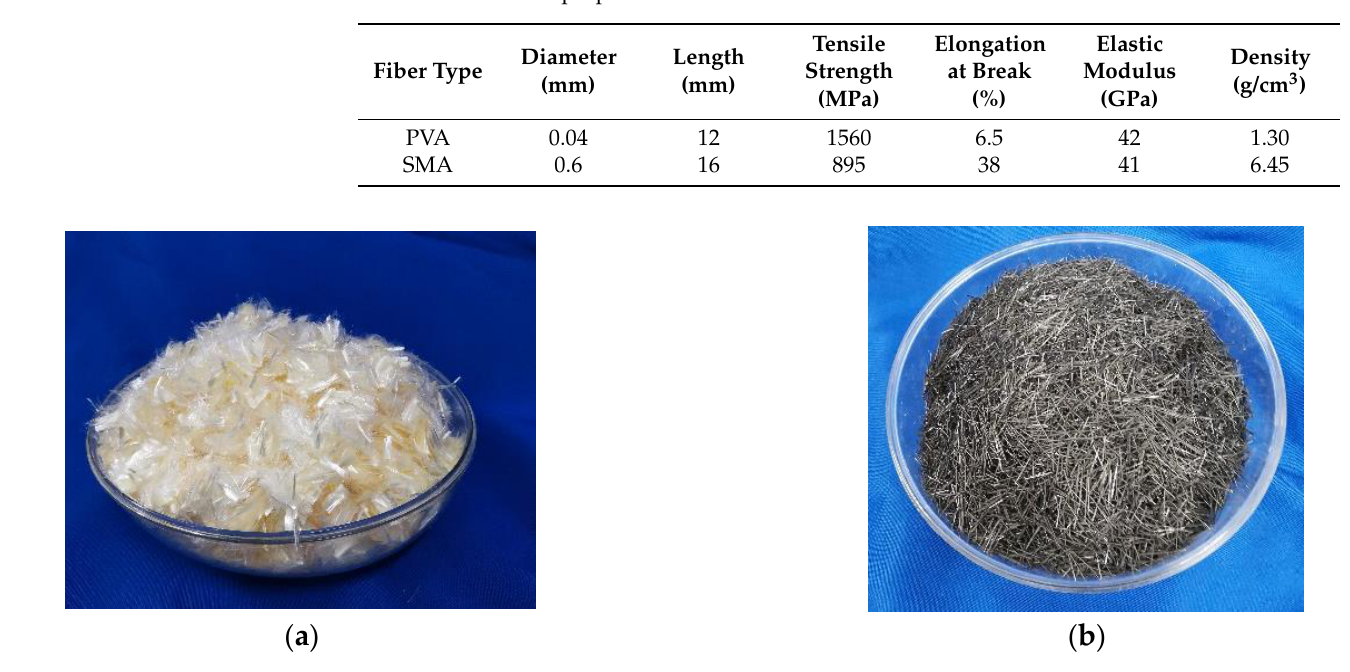
Table 3. Mix proportion of SMA-ECC.